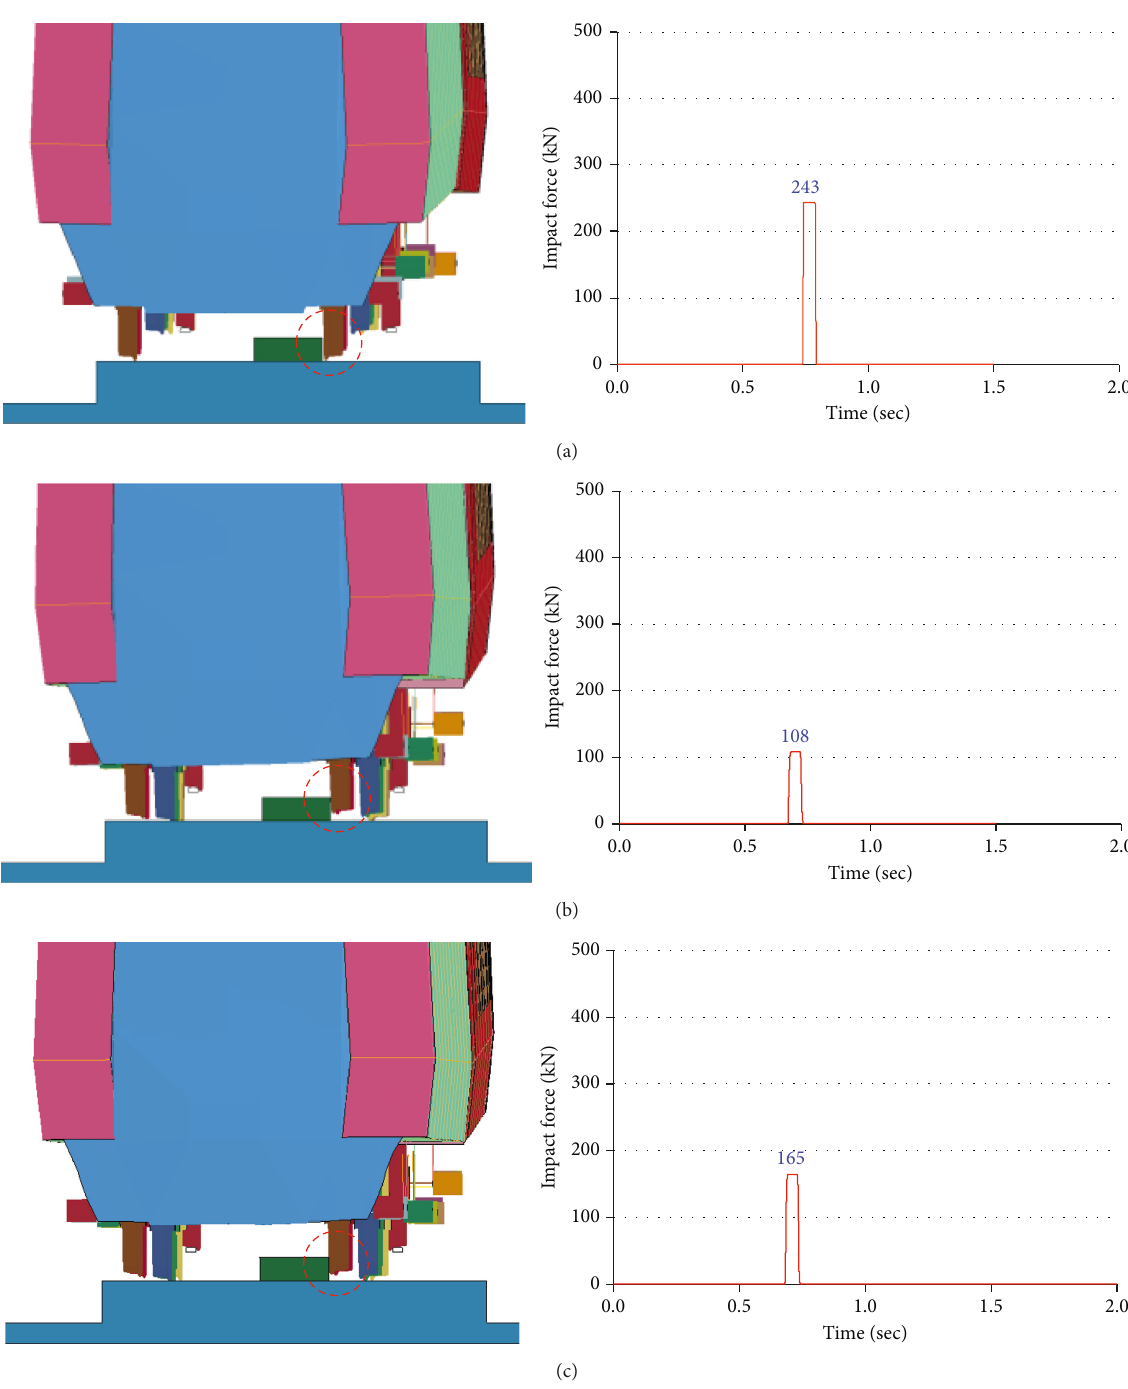
Figure 24: Derailment-collision behavior and impact force (alternative method). (a) Derailment-collision behavior 1. (b) Derailment- collision behavior 2. (c) Derailment-collision behavior